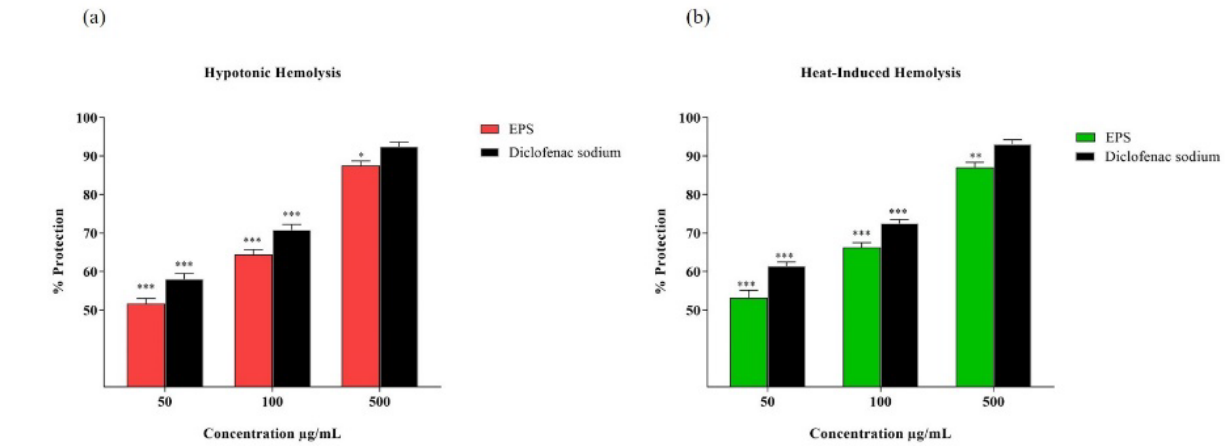
Figure 7. Membrane stabilization activity of Virgibacillus dokdonensis VITP14 exopolysaccharide (EPS): ( a ) hypotonicity; ( b ) heat-induced erythrocyte lysis. Values are means and error bars indicate standard deviations ( n = 3). The results p < 0.05 (*), p < 0.01 (**), p < 0.001 (***) were considered as